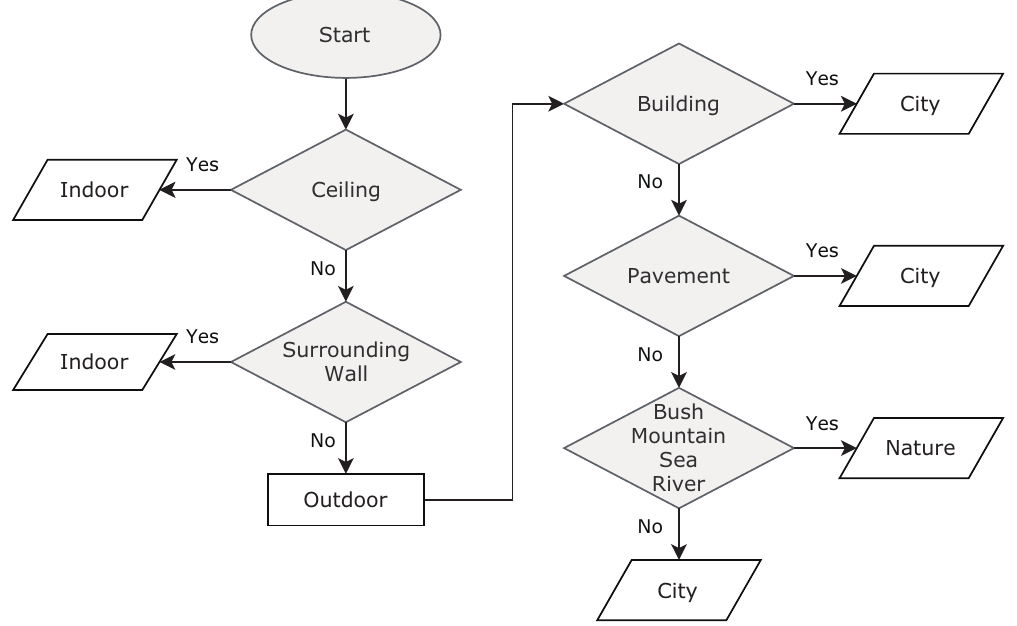
Figure 4. The criteria of labeling custom dataset. We first label the scene as either indoor or outdoor according to the existence of ceiling and surrounding wall. Then city images are labeled by buildings and pavements which are usually existing in urban area. Lastly, the scene is labeled as nature when there is nature stuff such as bush, mountain, sea, or